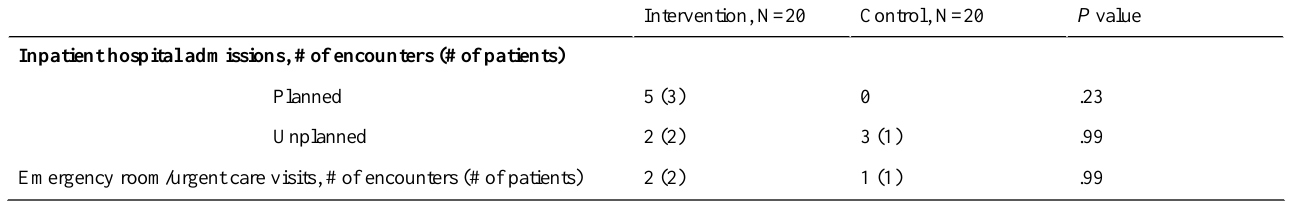
P valueControl, N=20Intervention, N=20